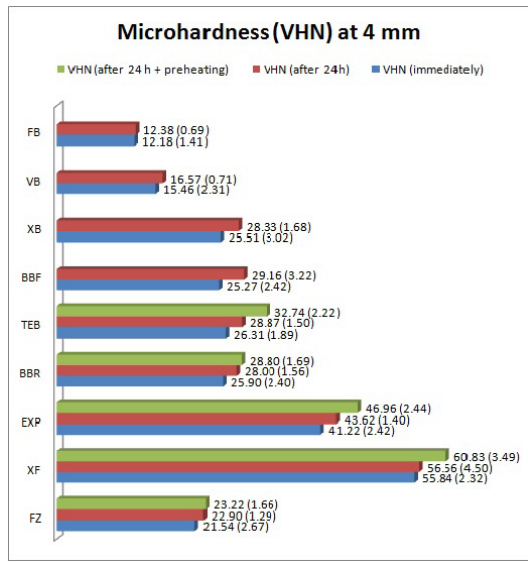
Figure 3. Mean values and standard deviations of microhardness expressed in VHN of all the experimental groups at 4 mm